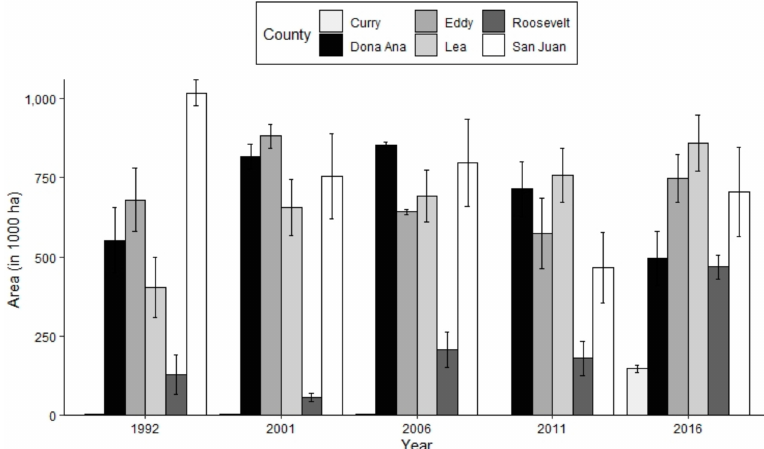
Figure 3. Area estimates of shrubland of the study counties from the